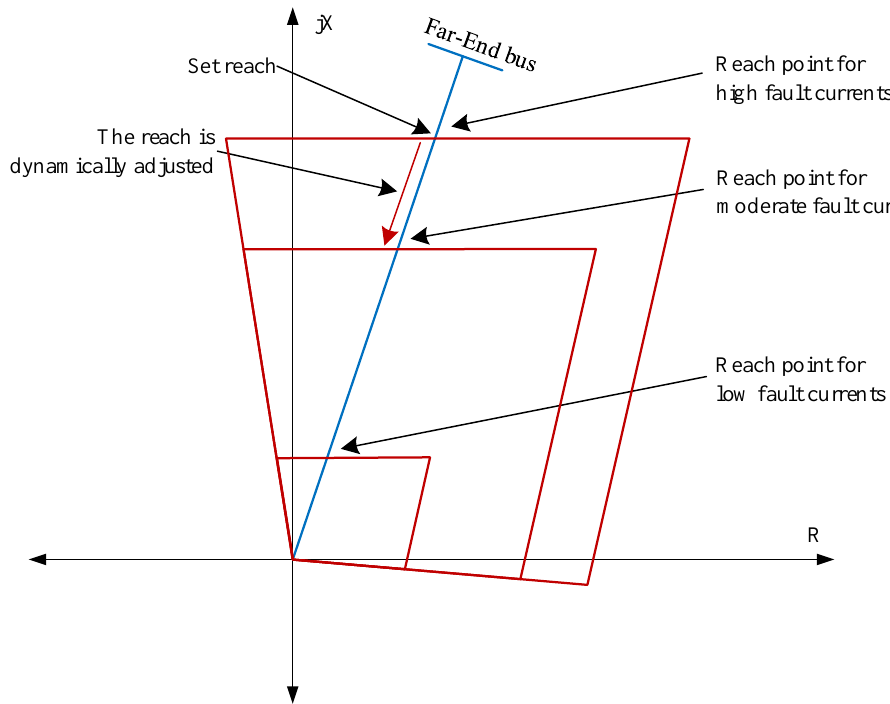
Figure 10. The current dependent adaptive reach of distance